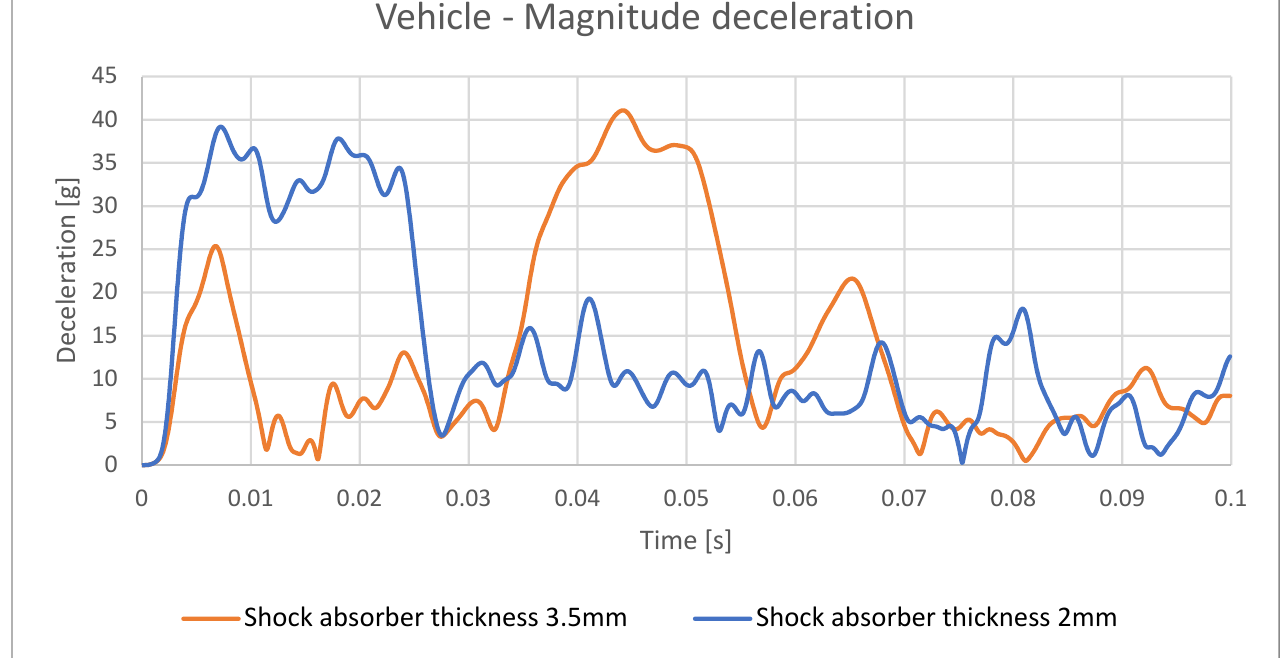
Figure 21. Deceleration of the vehicle at a shock of 7 m/s.